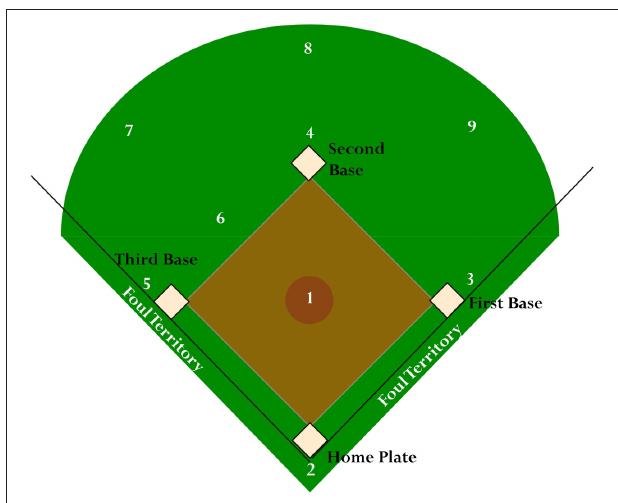
FIGURE A1 | Diagram of baseball diamond